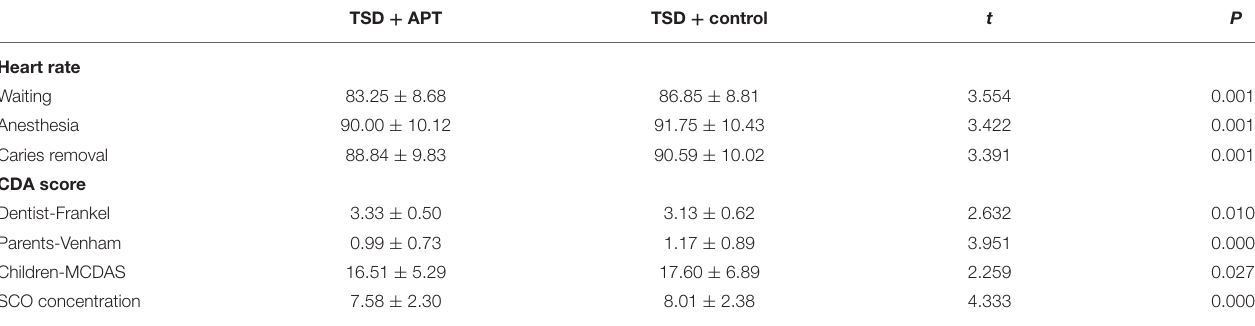
TABLE 1 | Comparison of TSD with and without